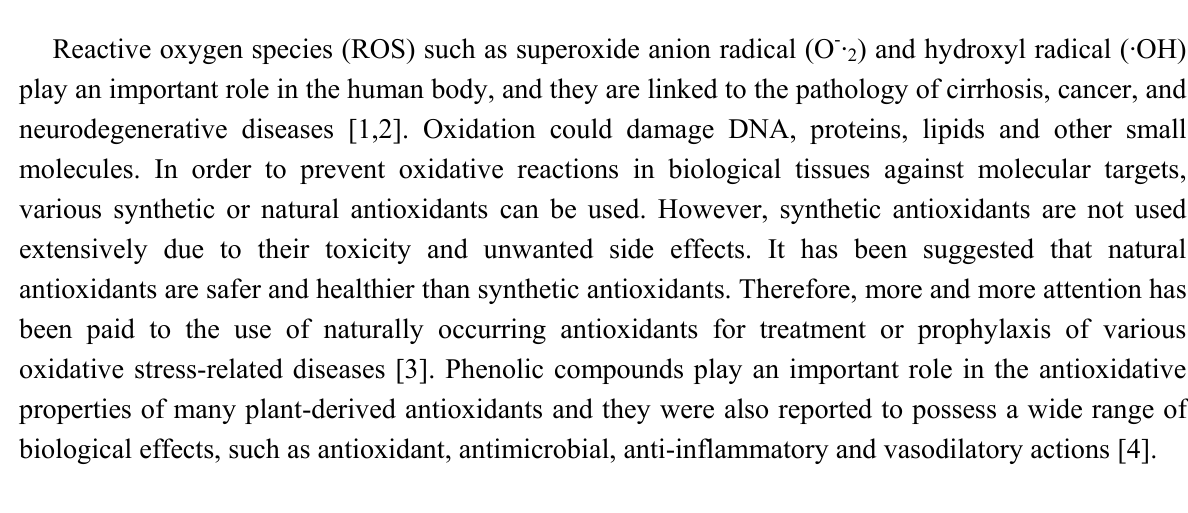
Figure 1. Structures of compounds 1 - 6